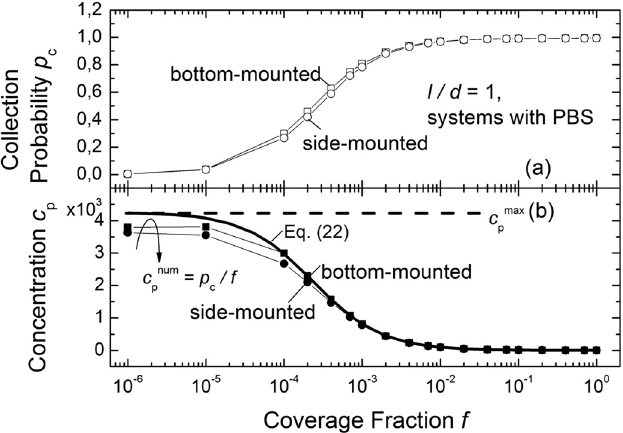
Fig. 6. (a) Collection probabilities p c for photons derived with a Monte-Carlo simulation for a side- and a bottom-mounted system in the statistical limit and with applied PBS. (b) Symbol-lines are the values for the concentration c p derived from p c in (a). Solid lines show the analytically calculated c p ( f ) from equation (22). Side-mounted system shows less agreement between the analytically and the numerically derived concen- tration because photons entering the system close to a solar cell are absorbed with a higher probability. This leads to an inhomogeneous chemical potential μ for the incoming photons which violates the assumptions for the calculation. But, the approach μ = const. is a good approximation in the statistical limit for the bottom-mounted solar cells